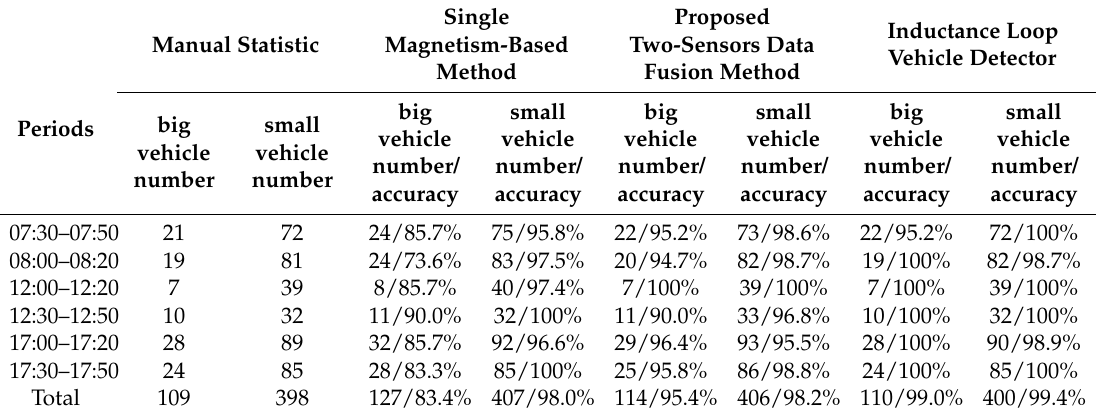
Table 1. Short-term vehicle detection statistical results.